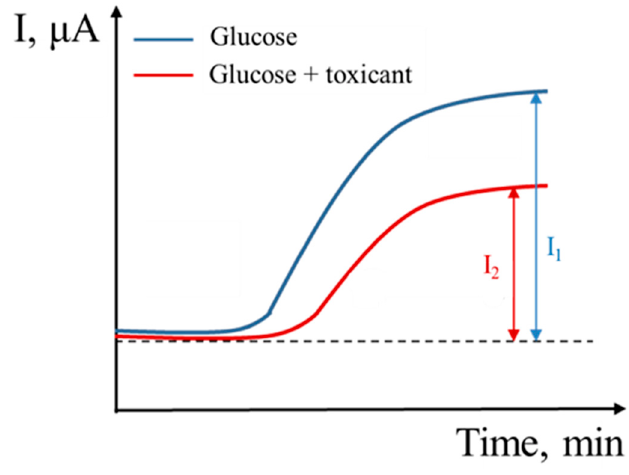
Figure 2. Scheme of analytical signal registration.